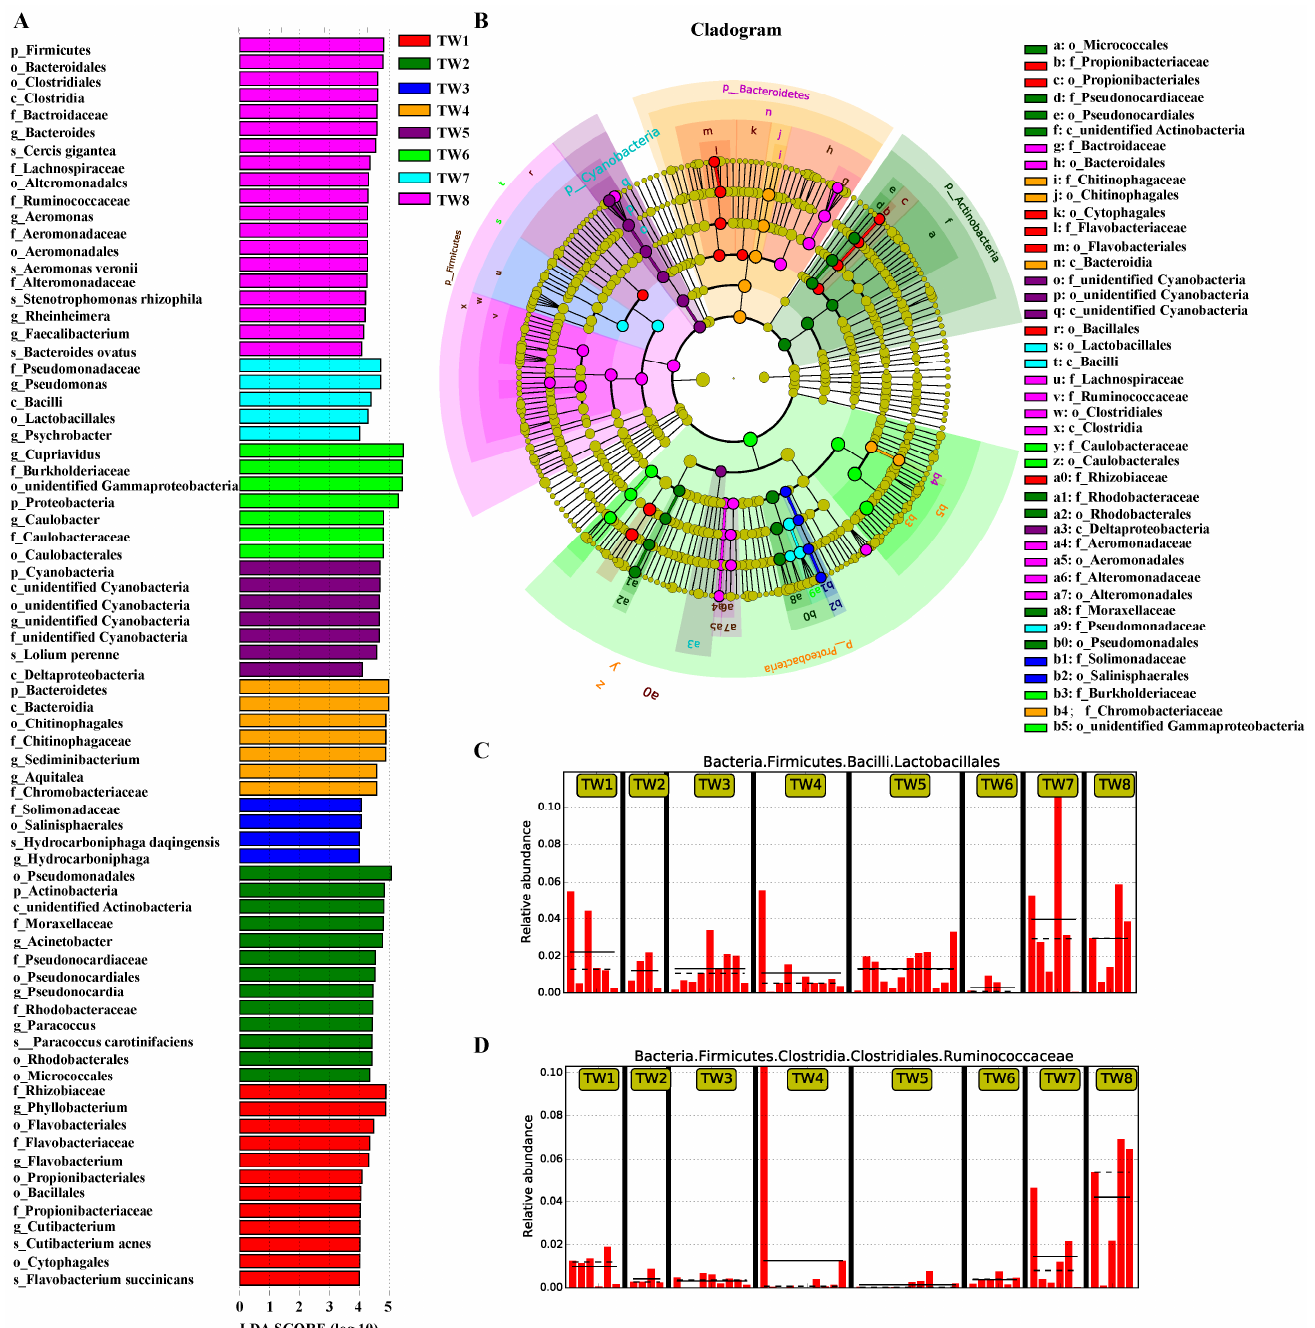
Figure 4. Significance analysis of species differences between groups. ( A ) Histogram of LDA value distribution of species with significant differences in abundance between groups; ( B ) Evolutionary clade of species with significant differences in abundance between groups; ( C , D ) Species with significant differences in abundance between groups- Lactobacillales and Ruminococcaceae